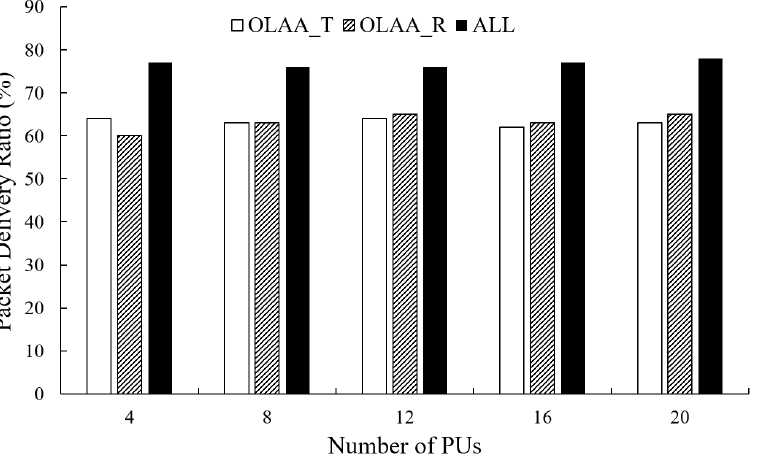
Figure 12. This figure presents the impact of the number of PUs on the performance of mesh topology in a synchronized network, as measured by the packet delivery ratio.